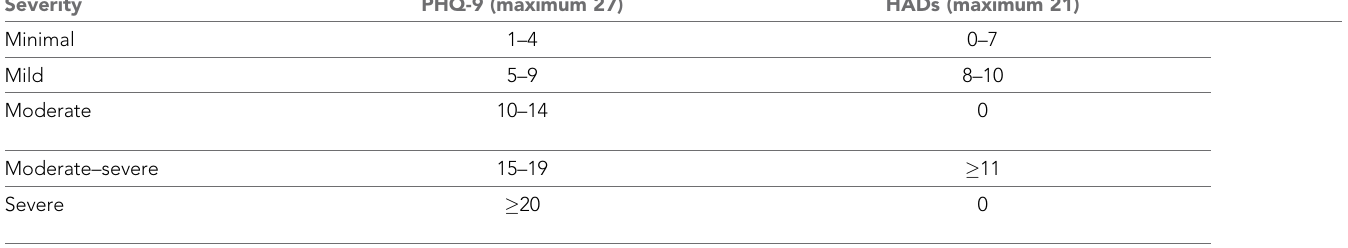
Table 1. Range of depression scores versus severity for PHQ-9 and